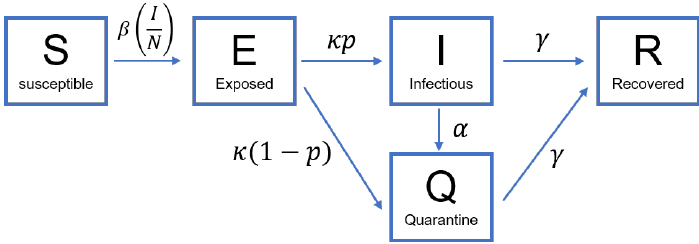
Figure 3. The flow chart of a single-patch model for COVID-19 transmission dynamics is